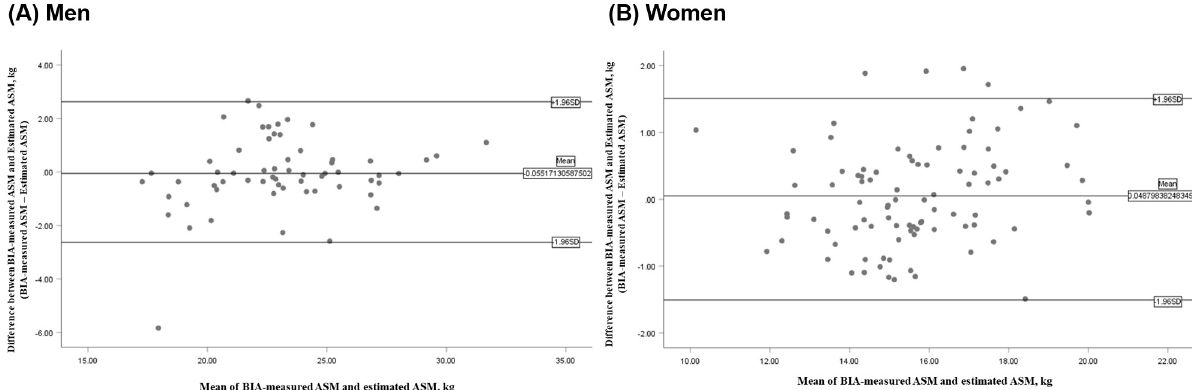
Fig 3. Bland–Altman plot for the agreement between the BIA-measured ASM and estimated ASM in the model development group. BIA, bioelectrical impedance analysis; ASM, appendicular skeletal muscle mass.